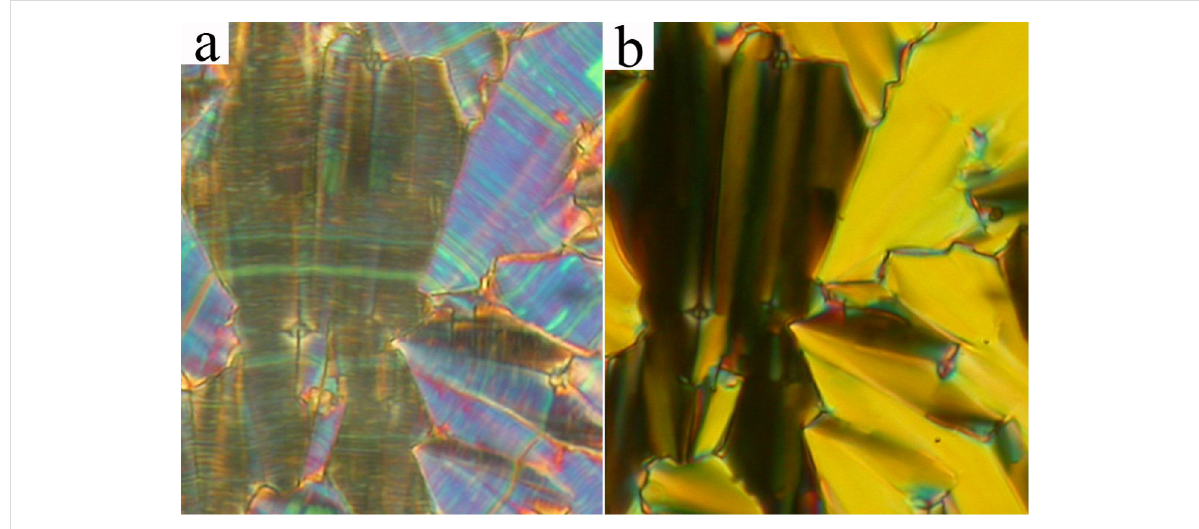
Figure 7: Planar texture of IIb compound the SmC S P A phase at T = 130 °C, (a) without applied field and (b) in the applied electric field +20V/ μ m. The width of each microphotograph corresponds to 250 μ m.